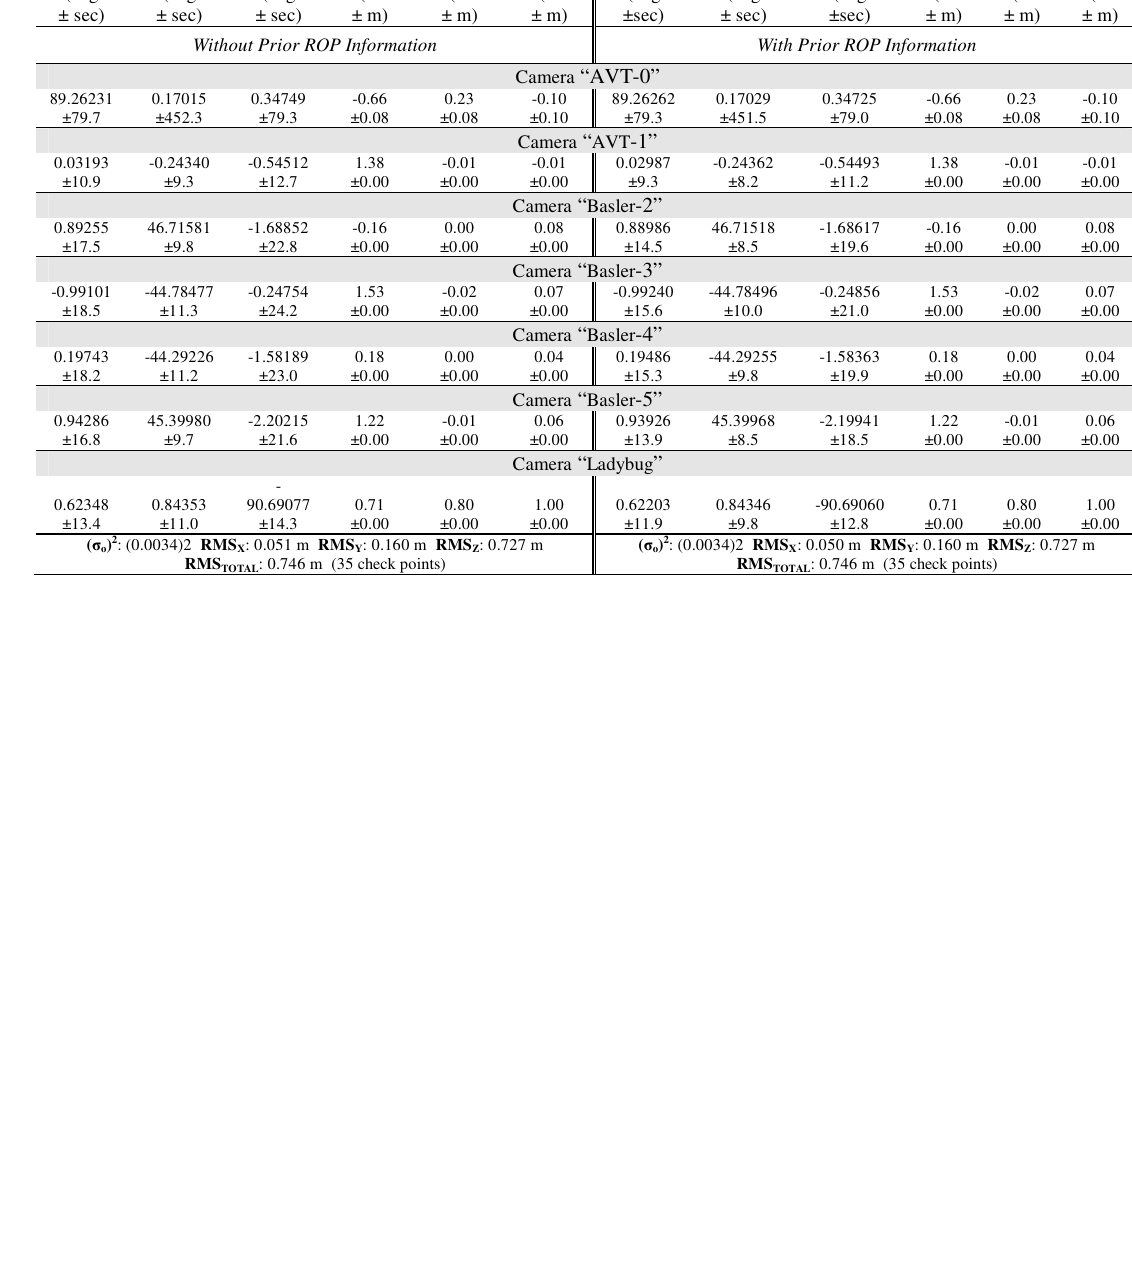
Table 3. System calibration results (i.e., estimated lever arm offset and boresight angles of the reference camera (i.e., camera “AVT- 0”) w.r.t. to the IMU body frame and the estimated/adjusted values for the ROP among the cameras, standard deviations, a-posteriori variance factor, and RMSE analysis – 35 check points) using 34GCP and the proposed ISO model without/with ROP prior information. ∆ω (deg ±